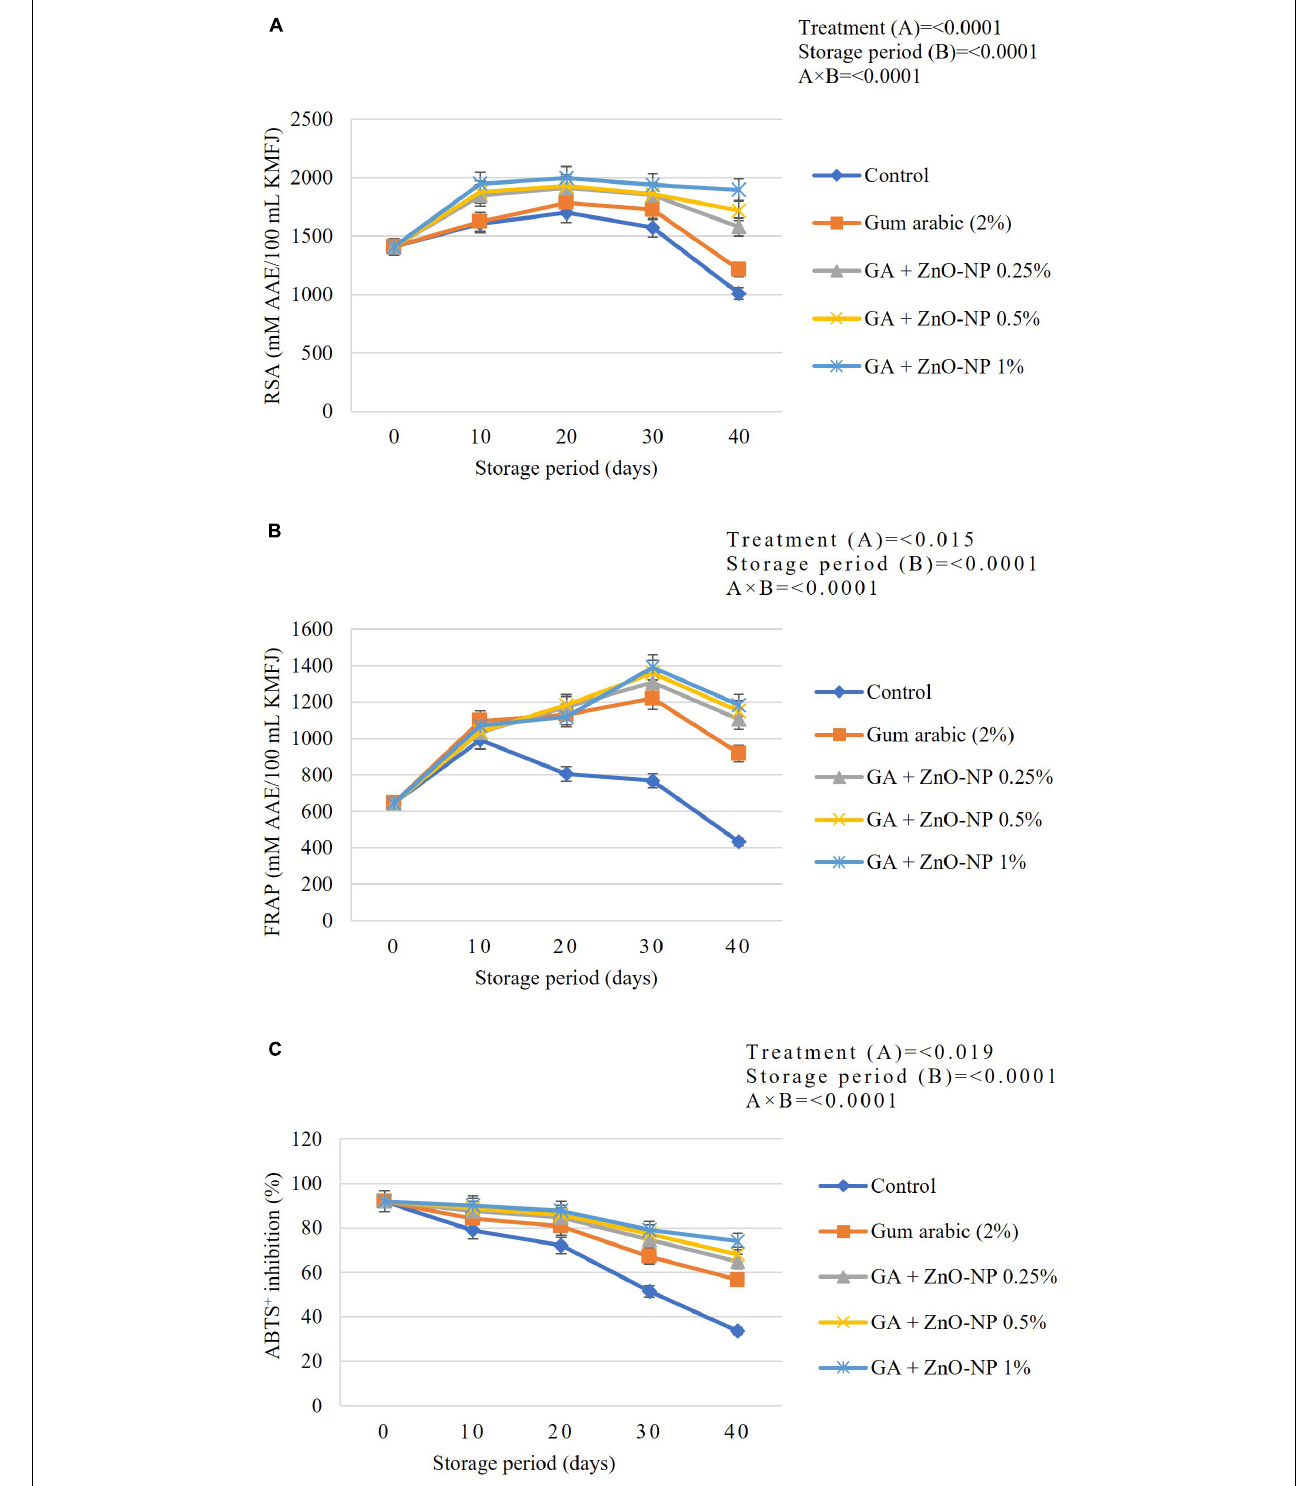
FIGURE 8 | (A) Radical scavenging activity (RSA), (B) ferric ion reducing antioxidant power (FRAP), and (C) ABTS + radical scavenging activity of ‘Kinnow’ mandarin fruit during storage for 40 days at 5 ± 1 ◦ C. Error bars denote the standard error (SE) of the mean. Means ± standard errors presented. To determine the interaction effects, factorial ANOVA was performed for the main factors, treatment, and storage time. GA + ZnO-NP, gum arabic + zinc oxide nanoparticles; AAE, ascorbic acid equivalent; TE, trolox equivalent; DW, dried weight; KMFJ, ‘Kinnow’ mandarin fruit juice; SE, standard error.